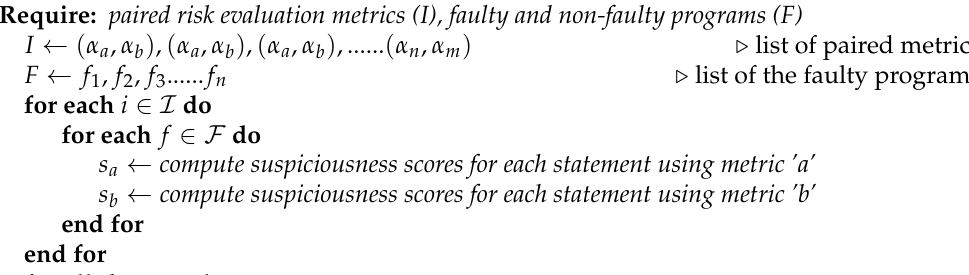
Algorithm 2 Metrics